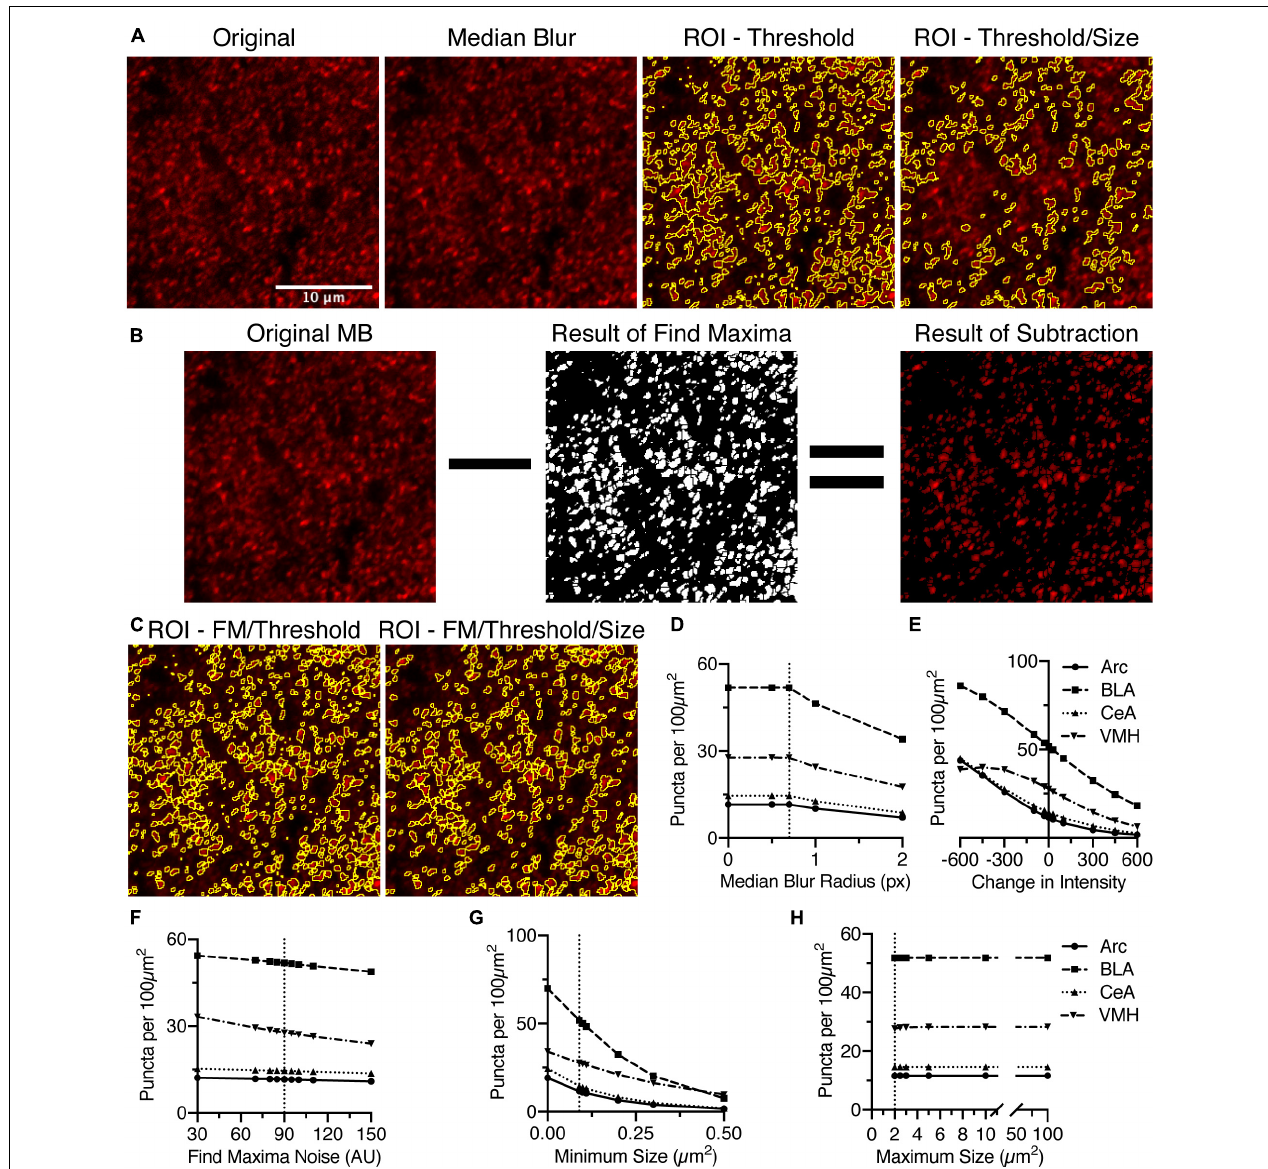
FIGURE 2 | Identification of puncta in densely labeled images requires a number of settings, but is most affected by the threshold intensity and the minimum size. (A) Anti-bassoon staining in BLA is densely labeled but clearly denotes puncta. Median blur with a sub-pixel radius removes noise without noticeably affecting the puncta. Identifying puncta using analyze particles above a minimum threshold, removing small and large puncta, leads to significant loss of most of the stained puncta. (B) Alternatively, the “Find Maxima” function (FM) identifies borders between puncta above the threshold using the segmented particles setting. This creates a black and white image, which with “Image Math,” can be used to remove pixels below threshold and create borders around closely spaced puncta. (C) Anti-bassoon puncta identified using thresholding and FM is further refined by using the analyze particles function to remove puncta outside a minimum and maximum size range (Size). Number of puncta identified in anti-bassoon staining in four brain regions is maximally, and universally negatively correlated with changes in intensity threshold (E) and a minimum size (G) . Sub-pixel median blur (D) , changes in the noise setting for FM (F) , and maximum size (H) have comparatively little effect on the number of identified puncta. Vertical dotted lines denote the original starting setting used for analysis. Scale bar denoted in panel (A) is 10 µ m for all